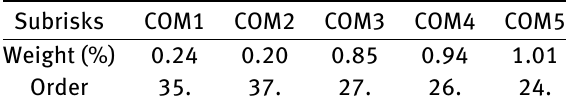
Table 7: Resulting values of subrisks weights – Part V.